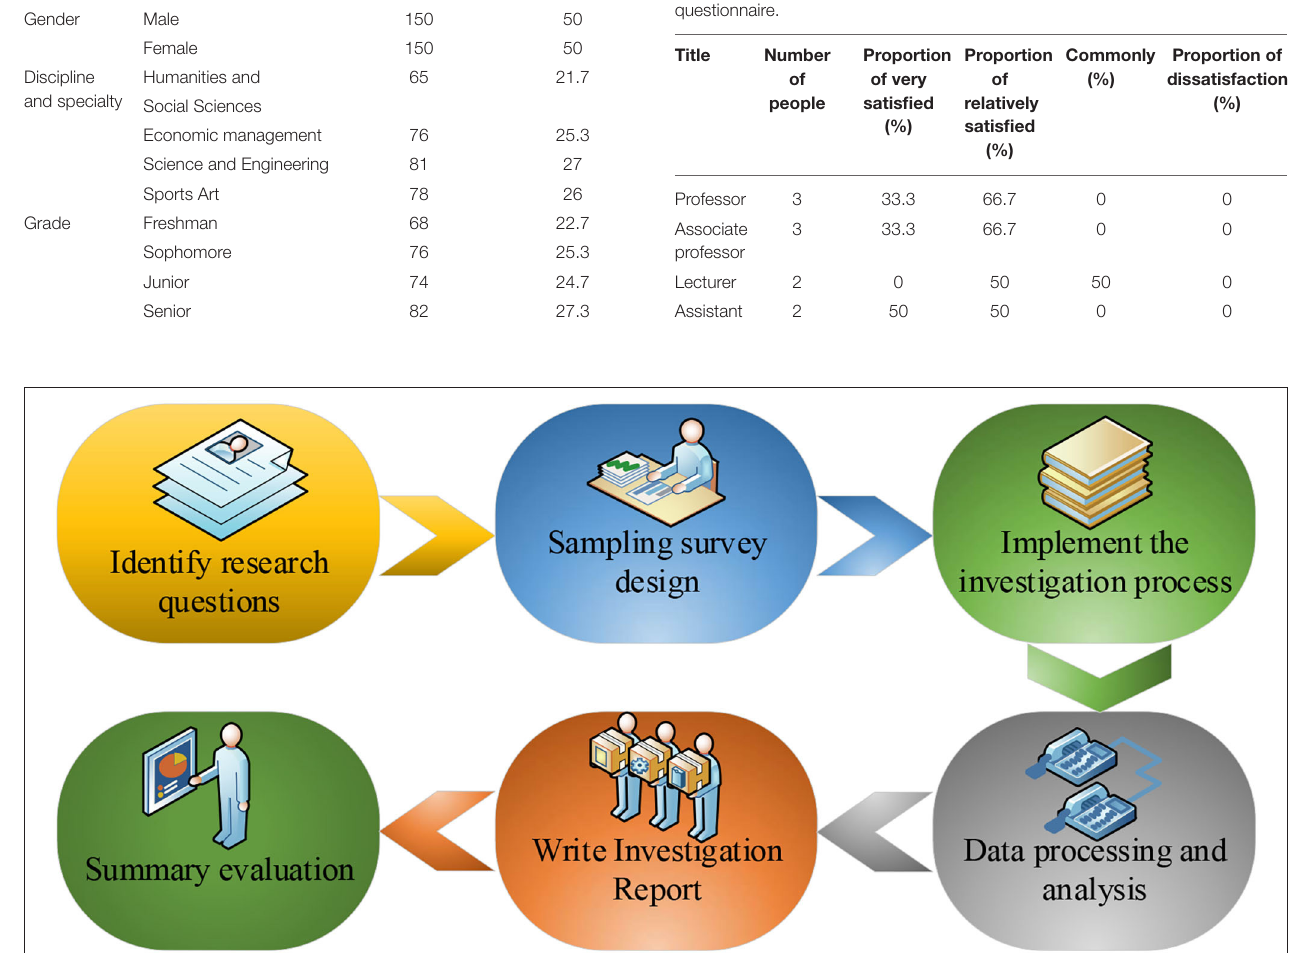
FIGURE 7 | The steps of investigation in the